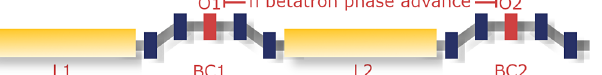
FIG. 1. Illustration of the proposed scheme showing the first linac section (L1), first bunch compressor (BC1) with embedded octupole (O1), second linac section (L2) and second bunch compressor (BC2) with embedded octupole